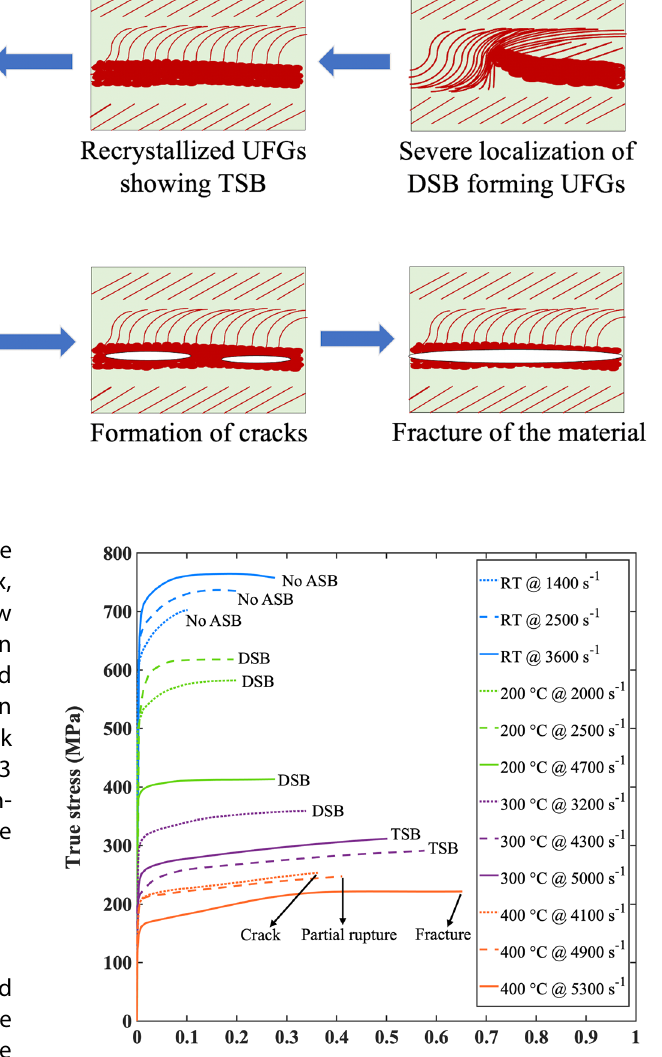
Fig. 15 Schematic repre- sentation of microstructure evolution leading to the failure of AA7075-T651 during high strain rate compression. The compression direction is per- pendicular to the figure plane